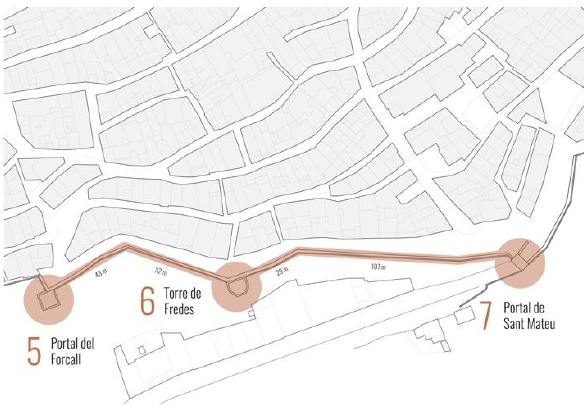
Figure 9. Section II of the “Walls Walking Tour” (Source: Morella Town Council, modified by S. Portela,